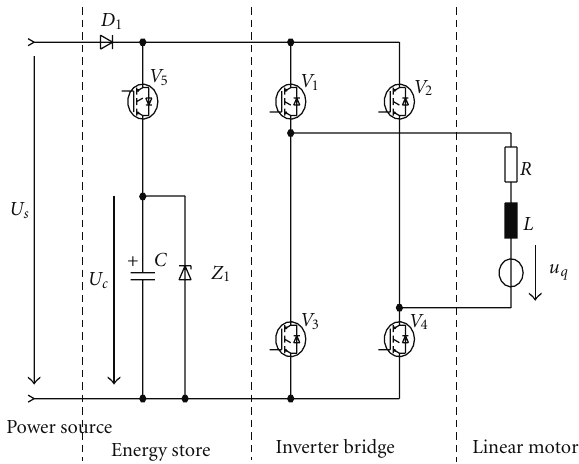
Figure 3: Multilevel inverter bridge